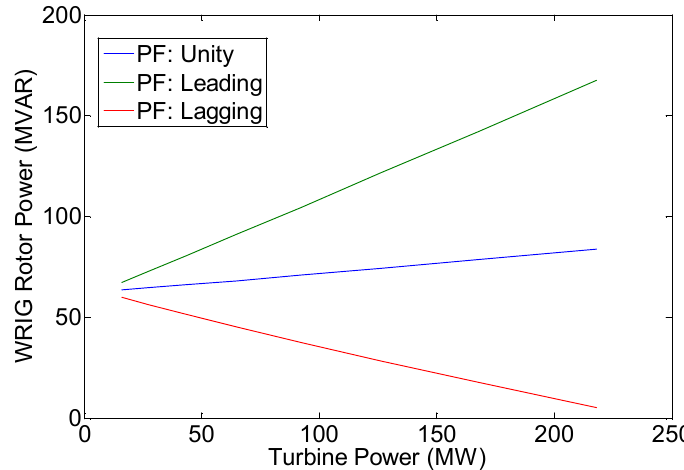
Figure 9. Variation of WPP reactive power output ( Q g ).